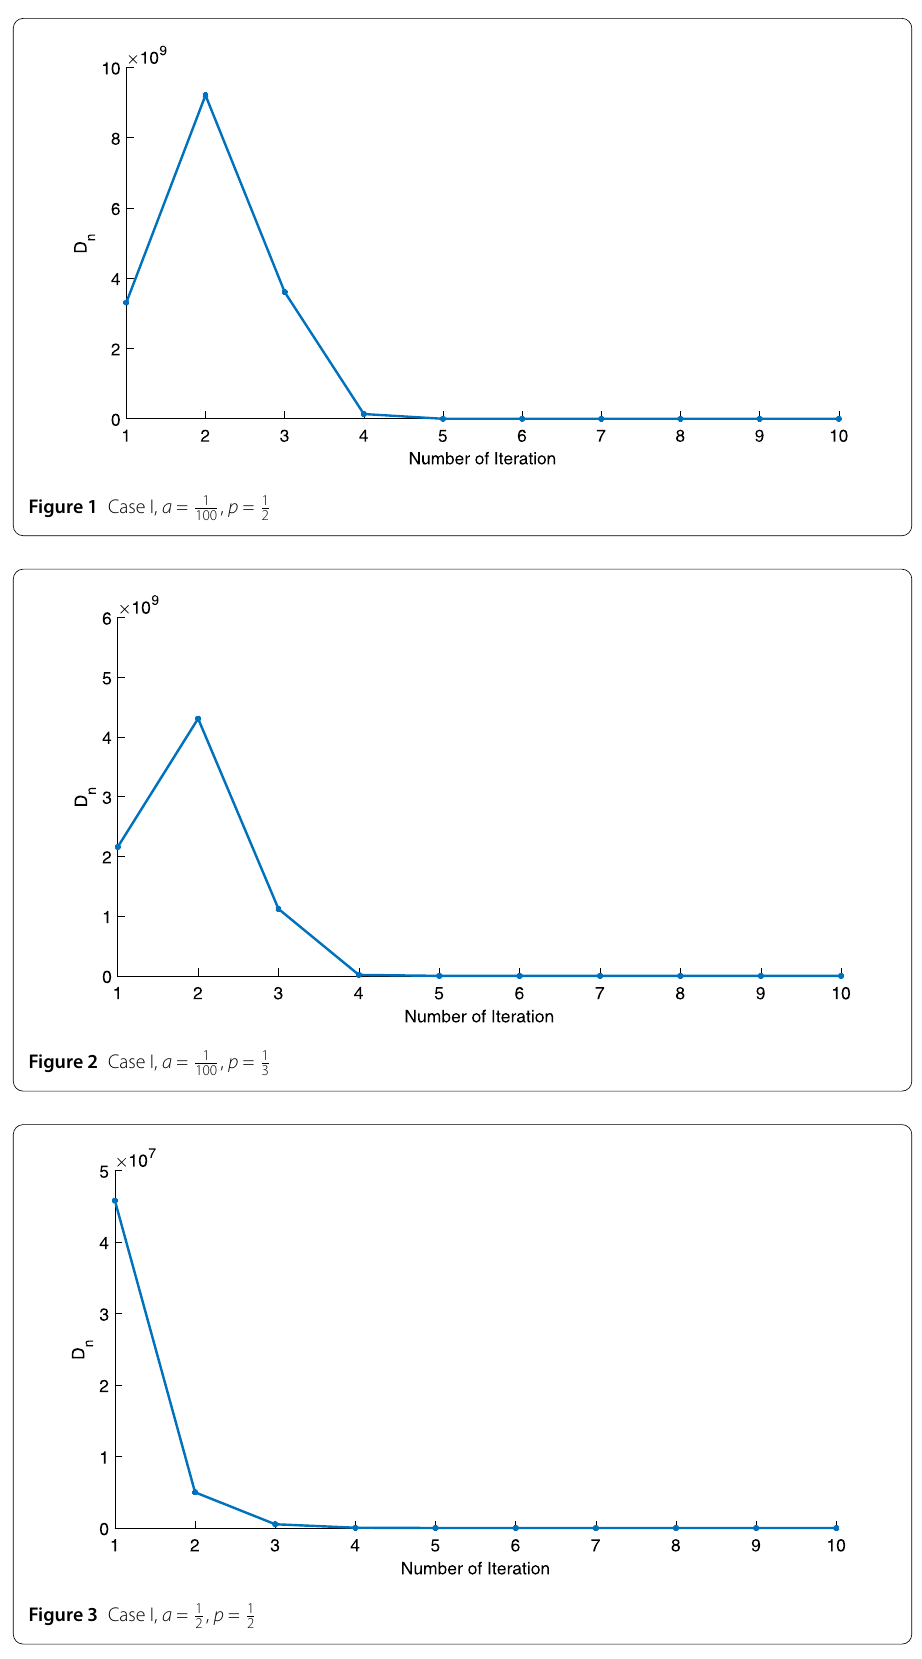
Figure 3 Case I, a = 1